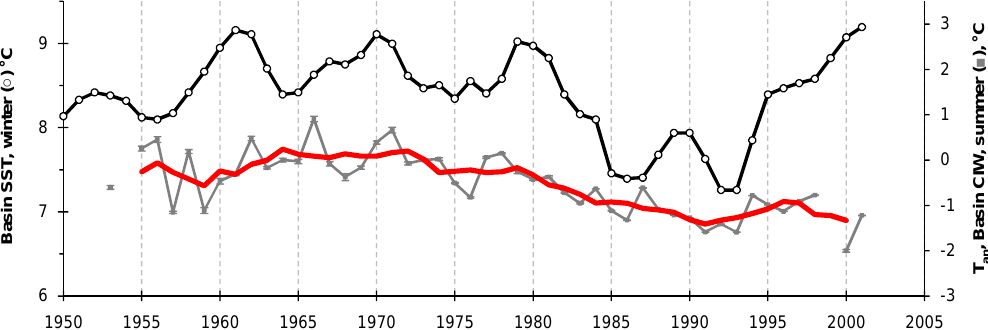
Fig. 10. Long-term time series of the mean sea surface temperature ( ◦ C) in winter averaged over the interior basin with depths greater than 1500m (thin black line + circles, redrawn from O˘guz et al., 2006) and time series of the summer (May–November) temperature anomaly ( T an , ◦ C) of Cold Intermediate Water (CIW) ( σ θ = 14 . 2–14.8kgm − 3 ) in the deep sea compartment (grey line + squares), and the 5-yr running mean (red line). Error bars show the standard error of the